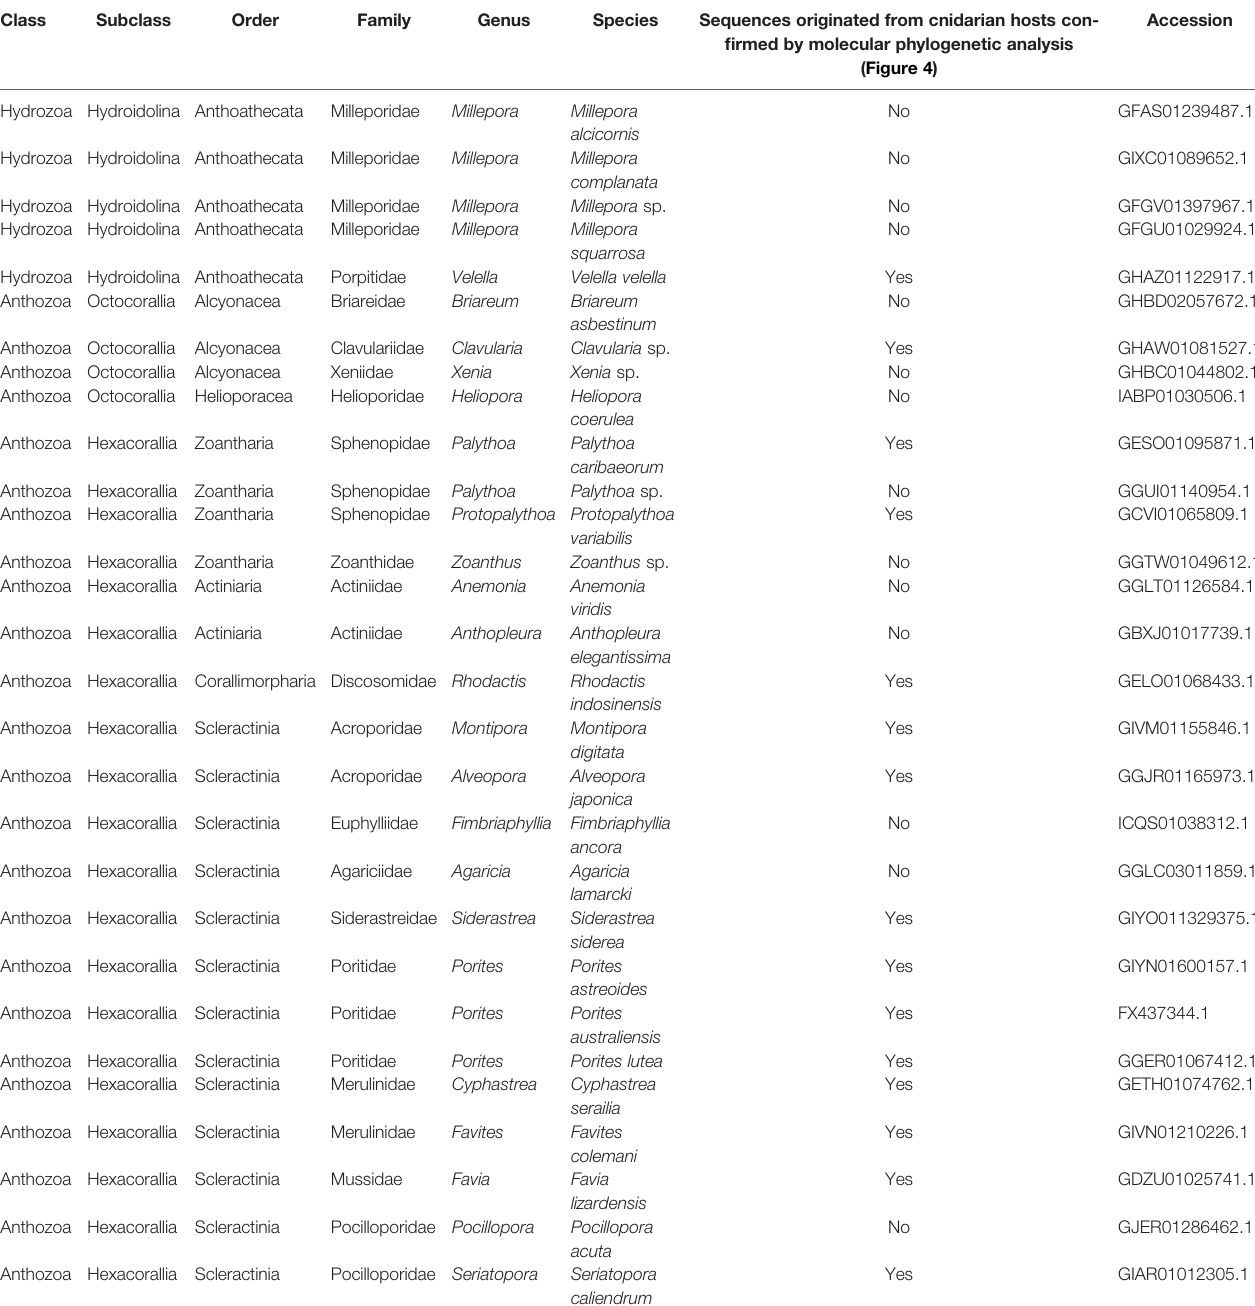
TABLE 2 | DL-L genes in cnidarians excluding Acropora